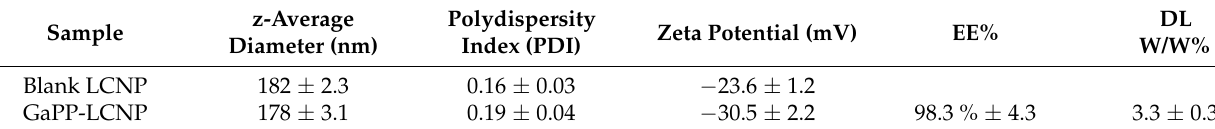
Table 1. Physicochemical characterization of nanoformulation.